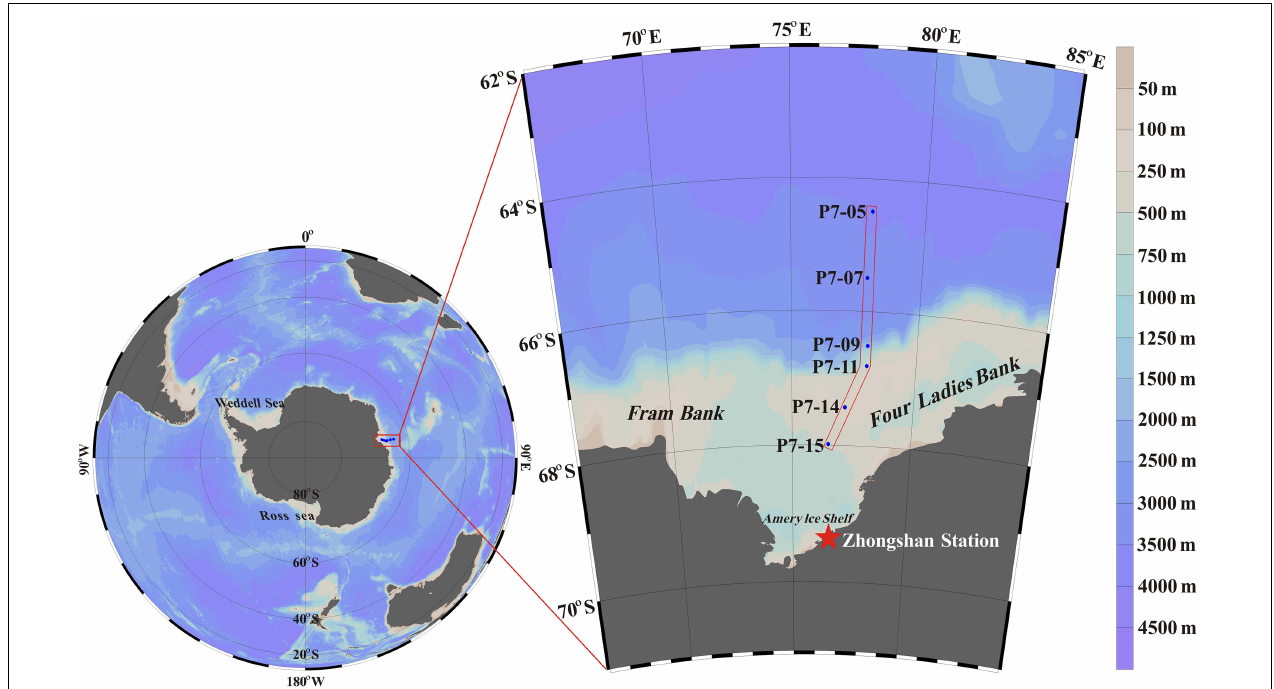
FIGURE 1 | Sampling locations around Prydz Bay. Stations P7-15, P7-14 and P7-11 are located in the shelf, station P7-09 is located in the slope, and stations P7-07 and P7-05 are located in the